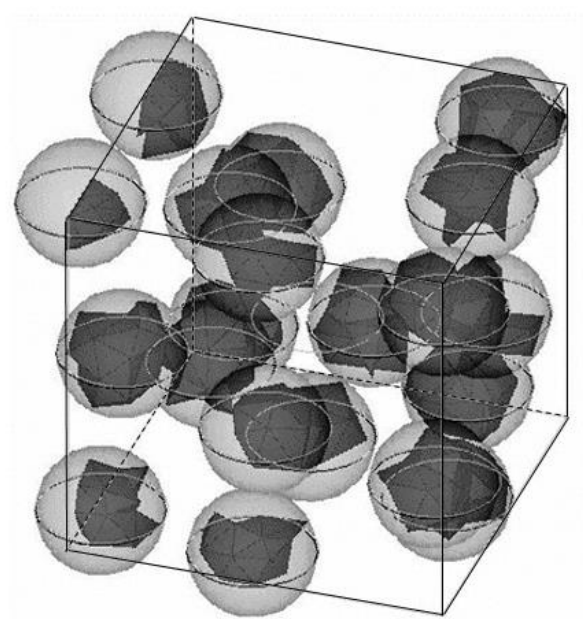
Fig. 7. A typical generated random spheres of 20mm radii along with associated stone aggregates inside a